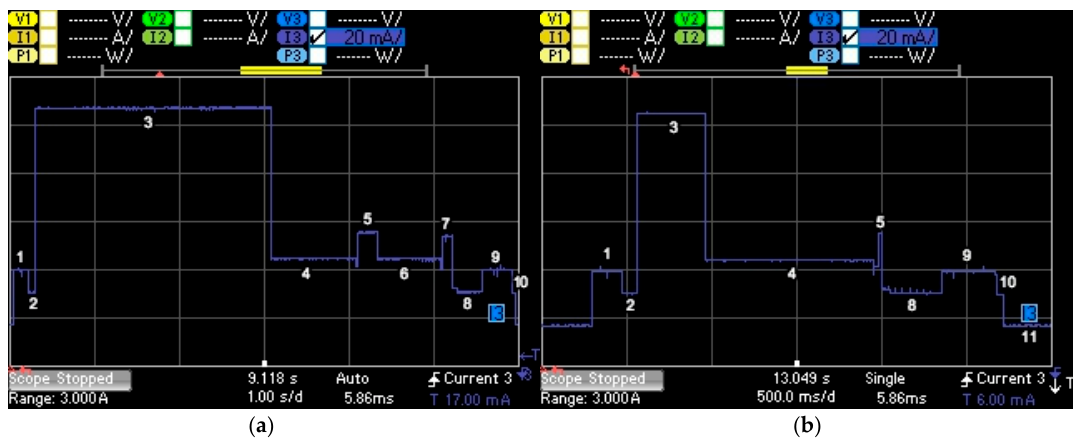
Figure 7. Current consumption profile of a MultiConnect mDot LoRaWAN end-device performing an acknowledged transmission: ( a ) with DR0 (left), ( b ) with DR5 (right). In the former, the acknowledgment is received by the end-device in the second window, whereas in the latter the acknowledgment is received in the first window. The data message transmitted by the end-device has a FRM Payload size of 51 bytes (left) and 242 bytes (right), respectively.